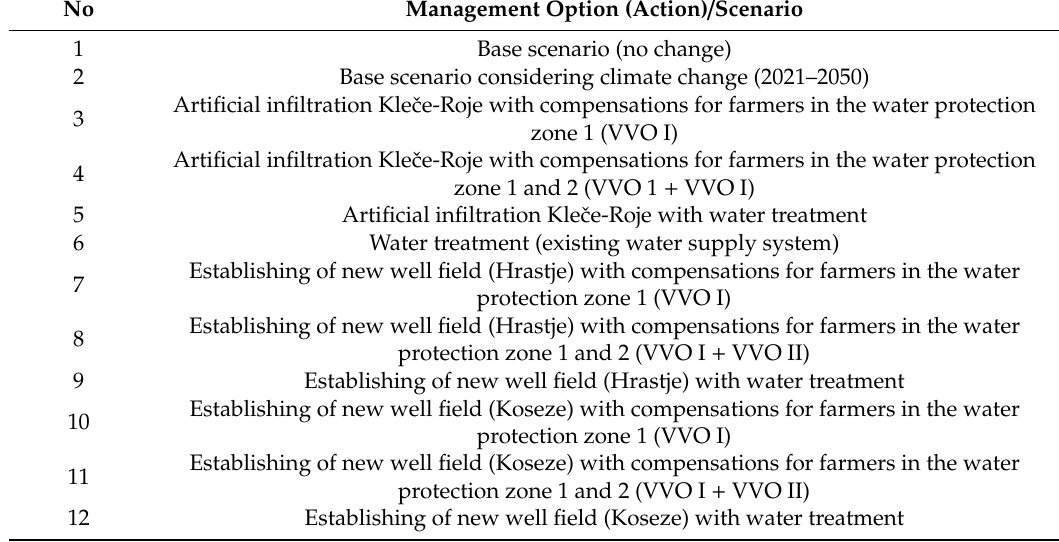
Table 1. Alternative management actions for the Ljubljana water supply regarding water quality assurance.